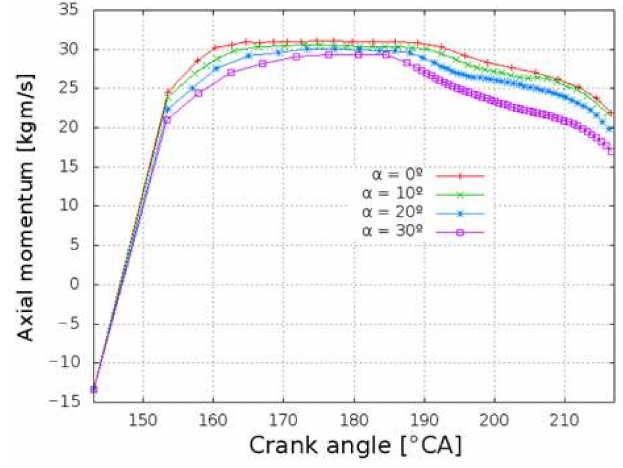
Figure 17. The variation of axial momentum over time for different scavenging port angles. The angular momentum, or swirl intensity, is presented in Figure 18. The graph shows that for greater inclination angles, the angular momentum rises faster and reaches higher values, as expected. The swirl intensity rises until the moment CA = 190 ◦ , after which it remains almost constant or decreases slightly. It is unclear why even the 0 ◦ angle port case gets a small angular momentum in the same direction, and it continues to increase even after CA = 190 ◦ . The more intense swirl motion for greater port angles can explain the smaller intensity of the axial momentum. The velocity of the scavenging air is directed so that it supports the swirling motion, and the energy is consumed to maintain the swirl. Less energy is used to push the fluid to the exhaust port, which results in smaller axial momentum.